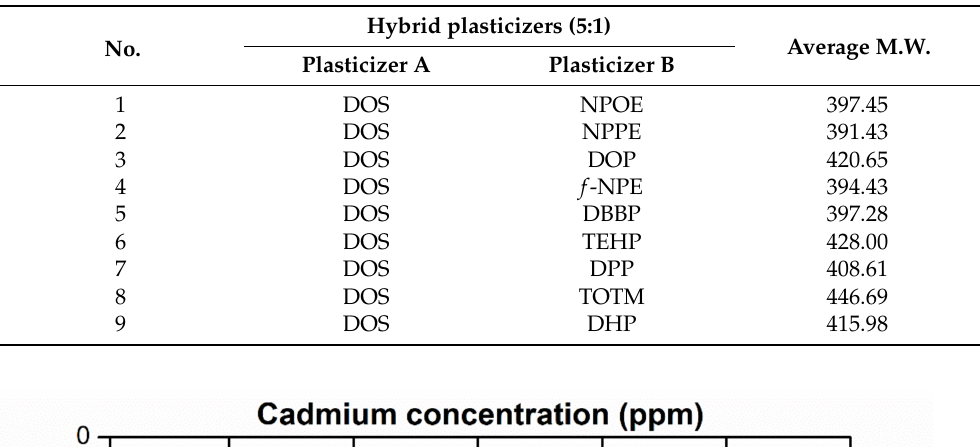
Table 2. The average molecular weight of the hybrid plasticizers.